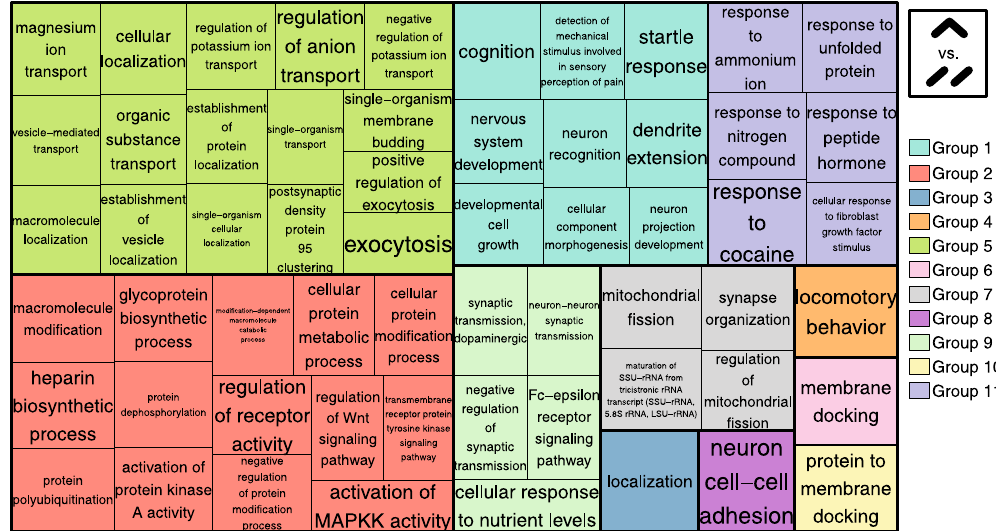
Figure 3. Shared GO Biological Process (BP) categories enriched for up-down genes. The 113 GO BP categories were chosen for showing a trend for enrichment in up-down genes (odds ratio > 1) in all 19 datasets (p = 0.017). The 113 categories were summarized by REVIGO 16 . Different colors show different superclusters and the size of each box is determined by the uniqueness of the